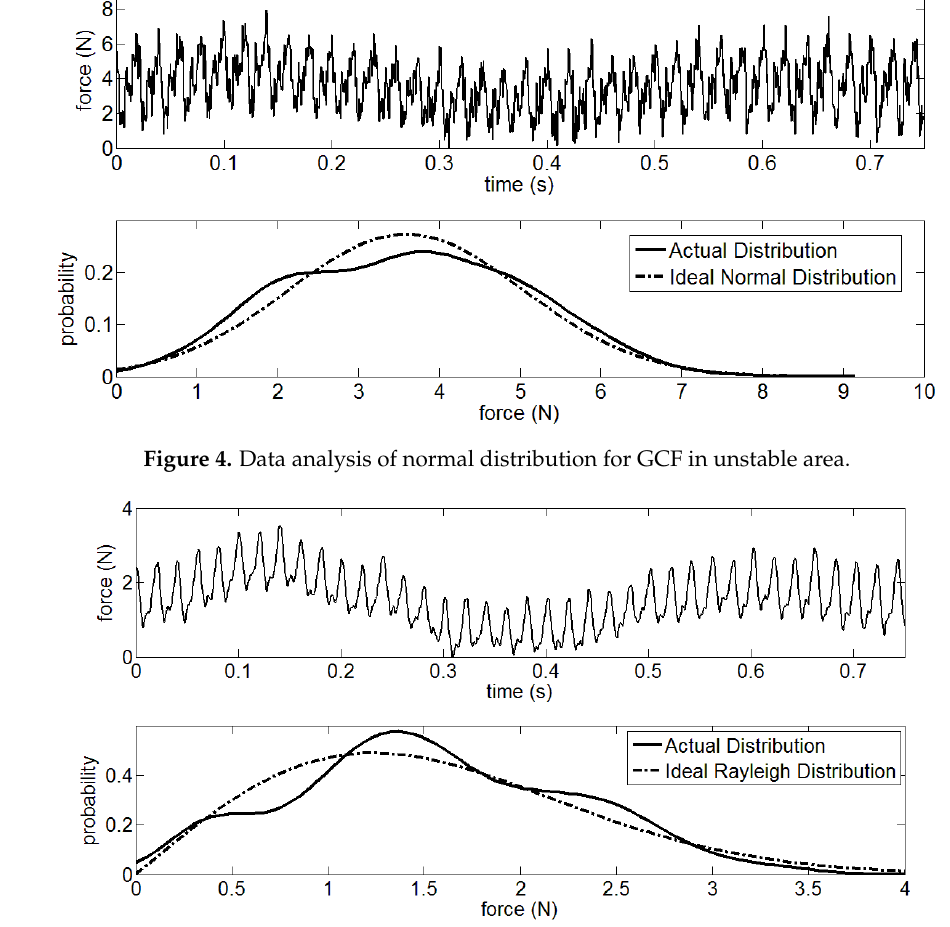
Figure 5. Data analysis of Rayleigh distribution for GCF in unstable area.